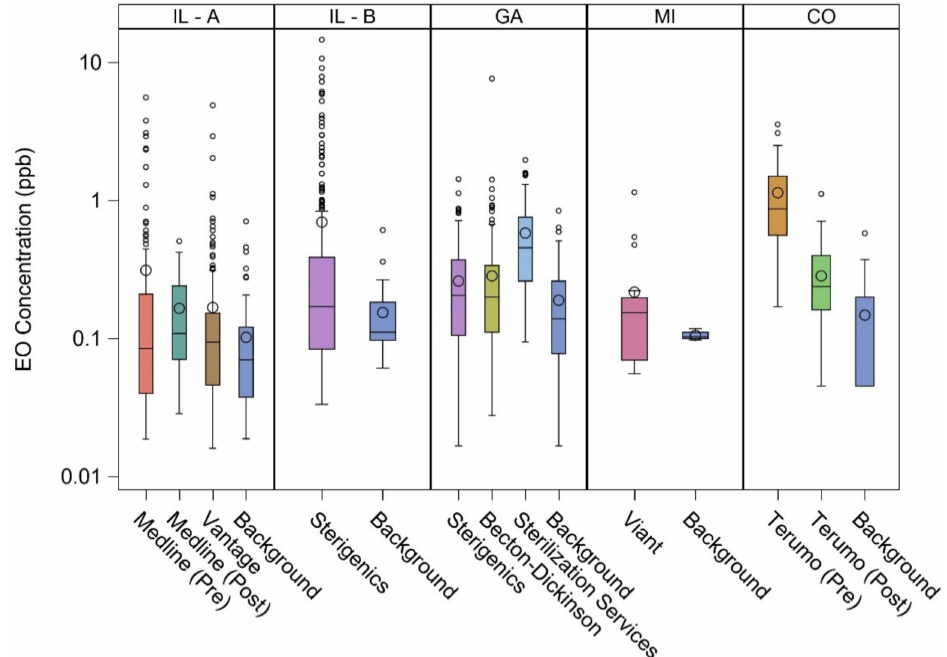
Figure 1. Distribution of ambient air EO concentrations in the vicinity of eight EO-emitting industrial facilities and at corre- sponding representative background locations. Length of box = interquartile range (IQR or P75–P25); horizontal line = P50; large circle = mean; lower whisker = P25 – (1.5 × IQR); upper whisker = P75 + (1.5 × IQR); small circle = potential outlier. Table 3. Statistical characterization of EO concentrations (ppb) in ambient air in the vicinity of eight EO-emitting industrial facilities and at corresponding representative background